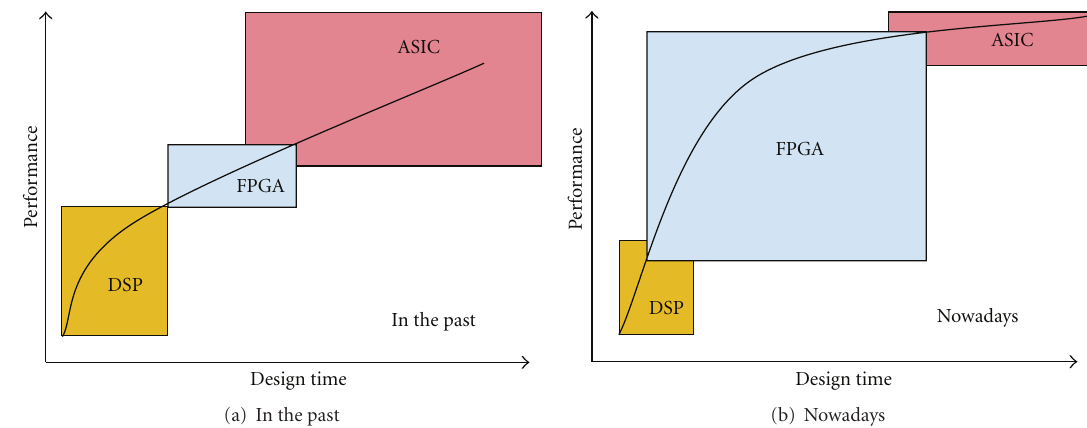
Figure 1: A comparison of DSP, FPGA, and ASIC embedded processors in terms of their characteristics in the past and